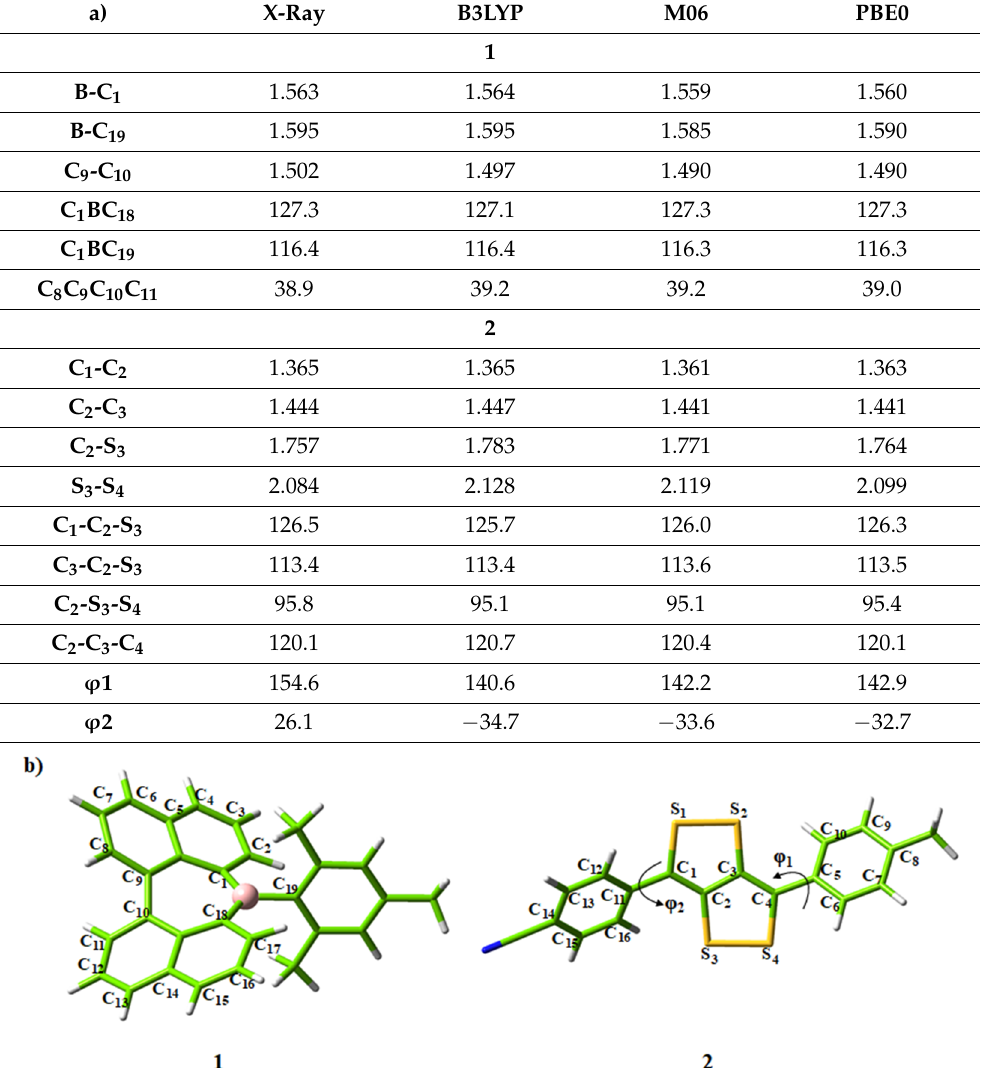
Table 1. ( a ) Main geometrical parameters for molecules 1 and 2, computed by using differ- ent exchange-correlation functionals by using the 6- 31+G* basis sets. The optimizations have been performed employing the Polarizable Continuum Model considering the chloroform and dichloromethane solvent for 1 and 2 , respectively. ( b ) Numeration of the considered parameters. a) X-Ray B3LYP M06